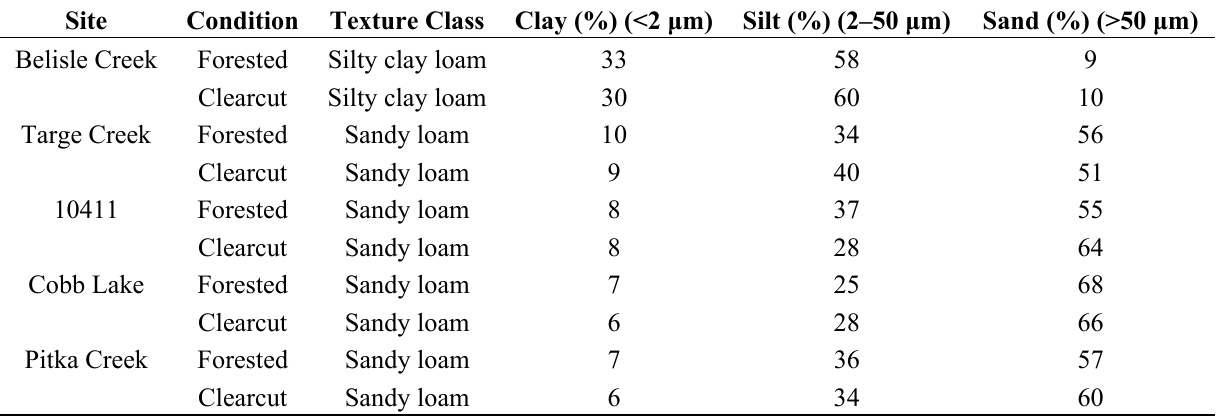
Table 3. Particle-size distribution in top 10 cm soil in the MPB and clearcut for the five selected sites ( n = 4).